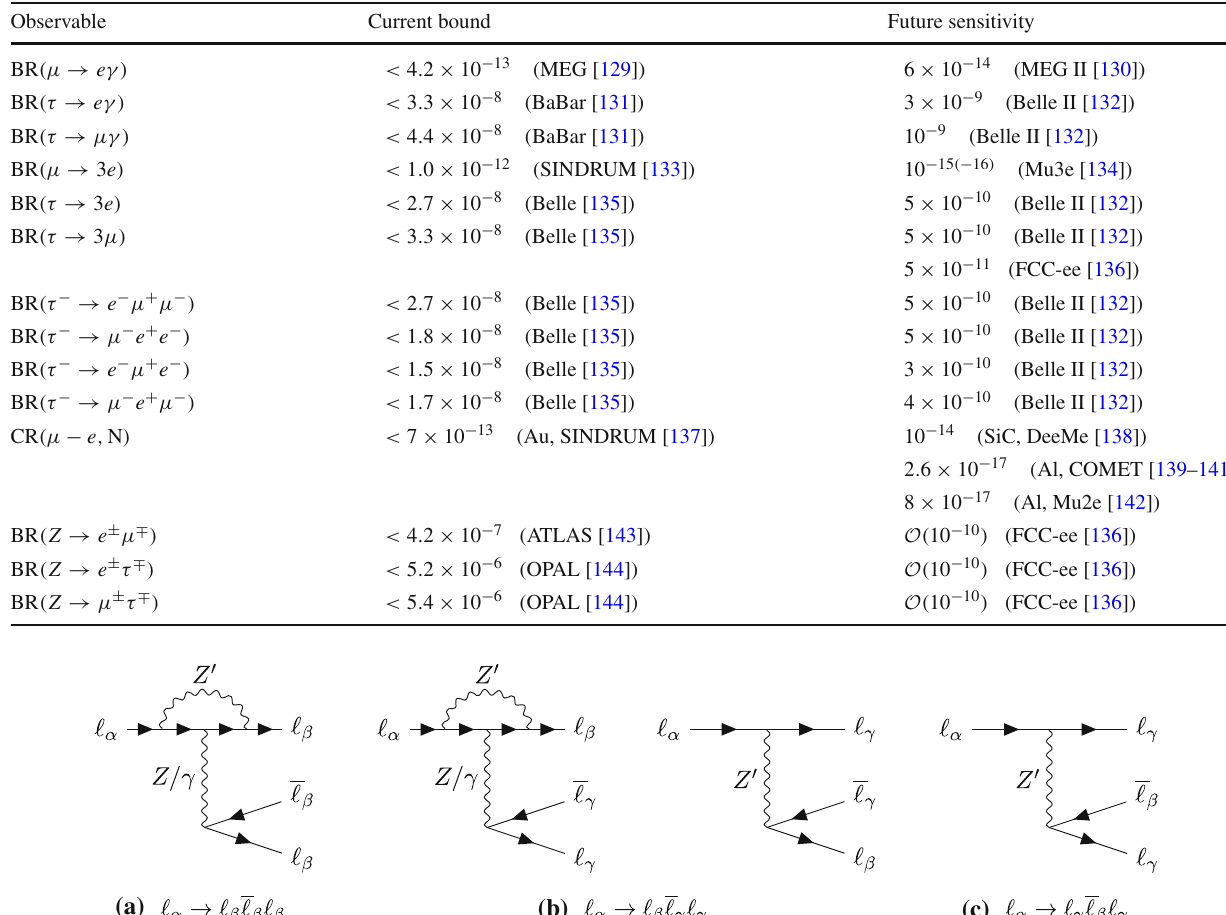
Table 1 Current experimental bounds and future sensitivities on cLFV observables considered in this work. All limits are given at 90%C . L . (notice that the Belle II sensitivities correspond to an integrated luminosity of 50 ab − 1 )